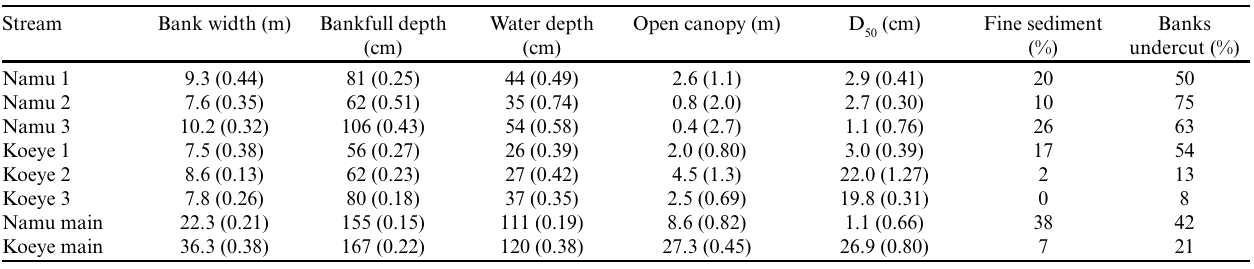
Table 2 . Summary of the transect level characteristics for each stream. Reported values represent the average over all transects within a stream with coefficient of variation values given within brackets. Fine sediment represents the percentage of particles with intermediate axis length less than 2 mm over all particles counted within a stream, and therefore no standard deviation value is given. Banks undercut represents the percentage of undercut banks over all transects within a stream.